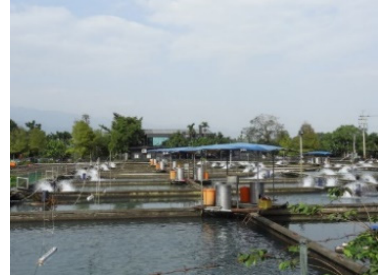
Figure 1. Fish farms in Taiwan.